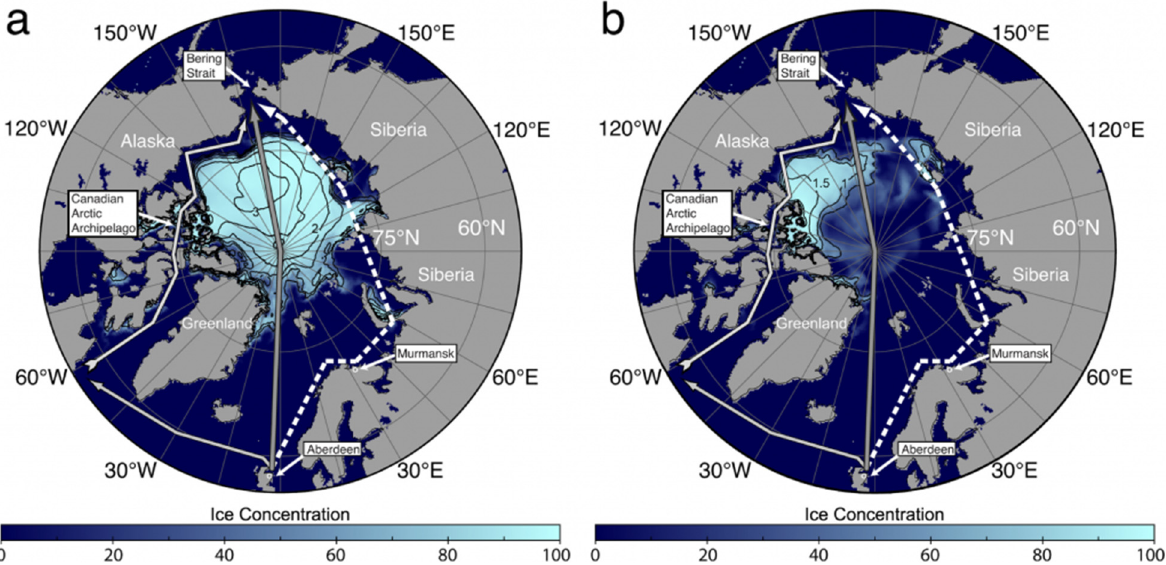
Figure 2. Model 2010–2019 ( a ) and 2030–2039 ( b ) sea ice concentration (%, shades of blue) and thickness (indicated contours) during the navigation period (June–October), according to the RCP 8.5 NEMO forecast. Source: [53]. Note that this figure shows the Arctic shipping routes: NSR (dashed arrow), Central Northern Passage (dark gray arrow), and Northwest Passage (light gray arrow).